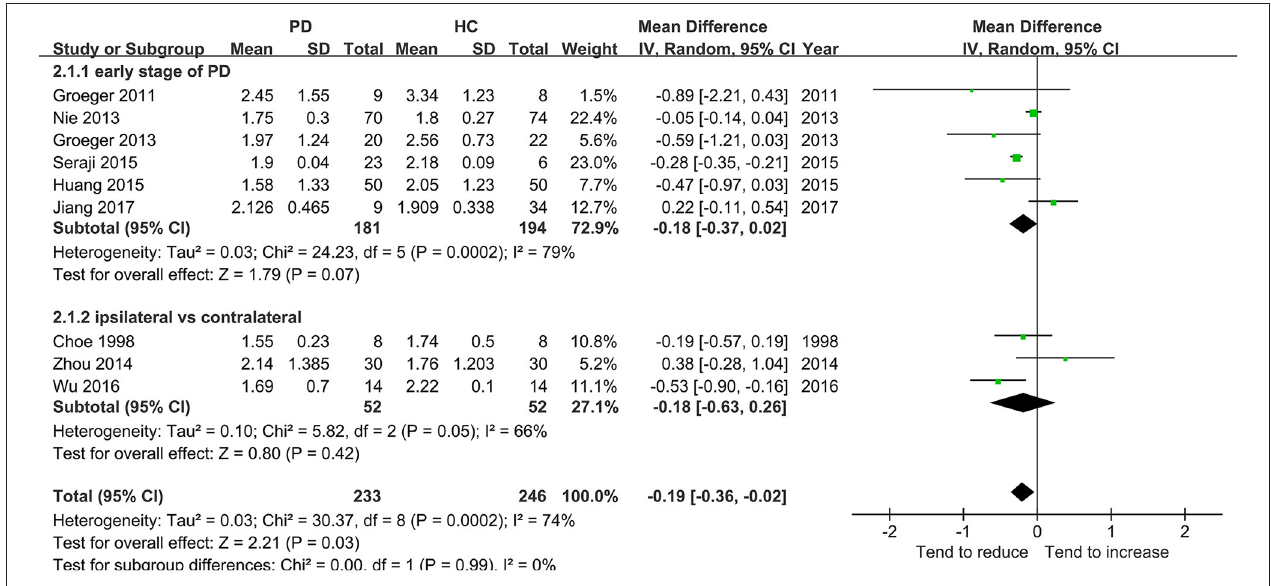
FIGURE 4 | Forest plot of the NAA-to-Cr ratio in SN in early PD vs. HC.